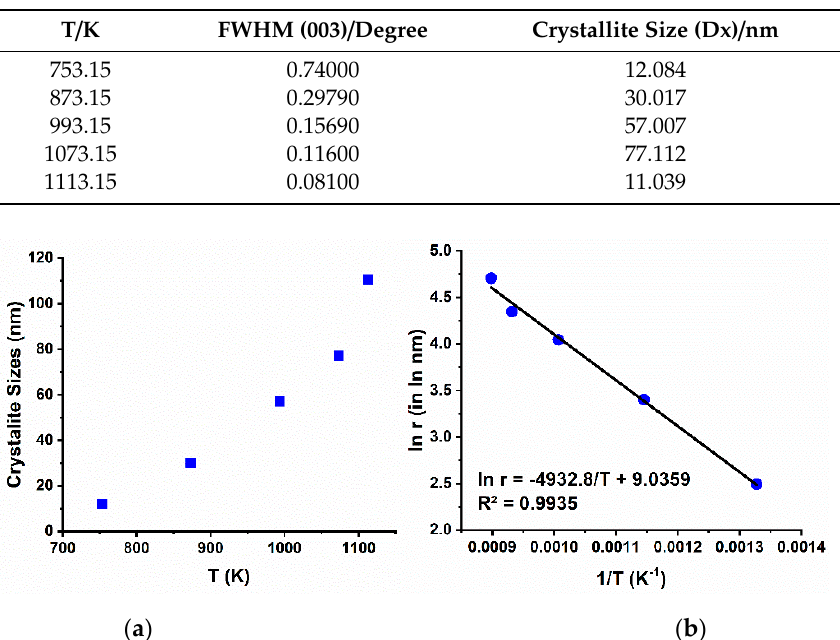
Table 3. Crystallite size vs absolute temperature of sintering.